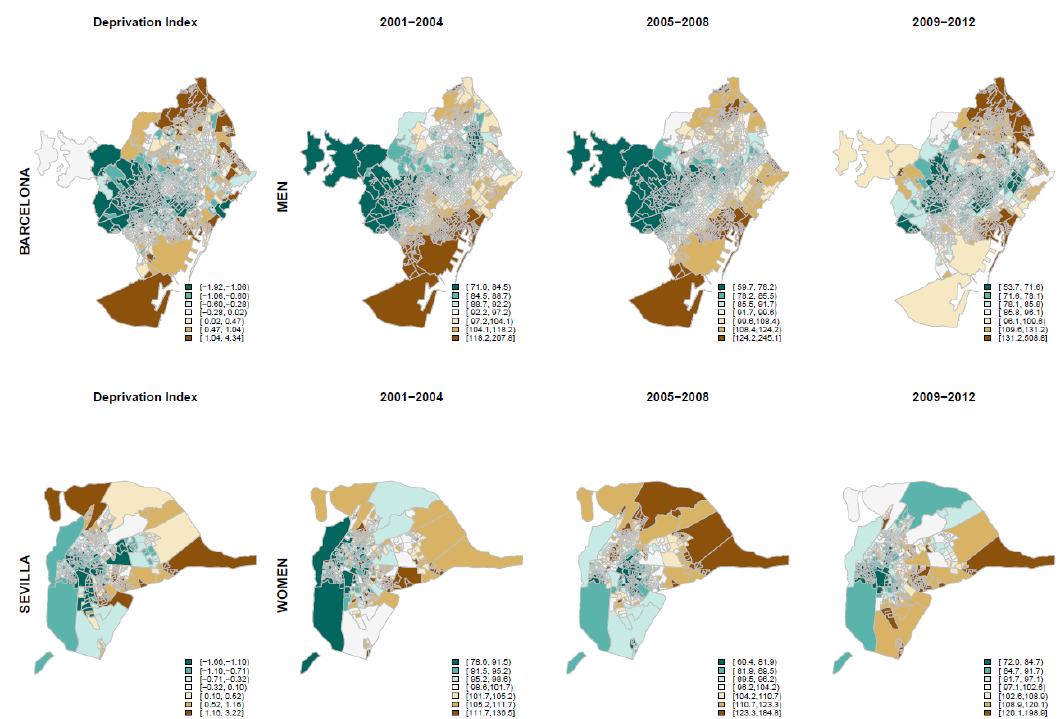
Figure 1. Deprivation index and Smootherd Standardized Mortality Ratios for the 3 periods among men in Barcelona and women in